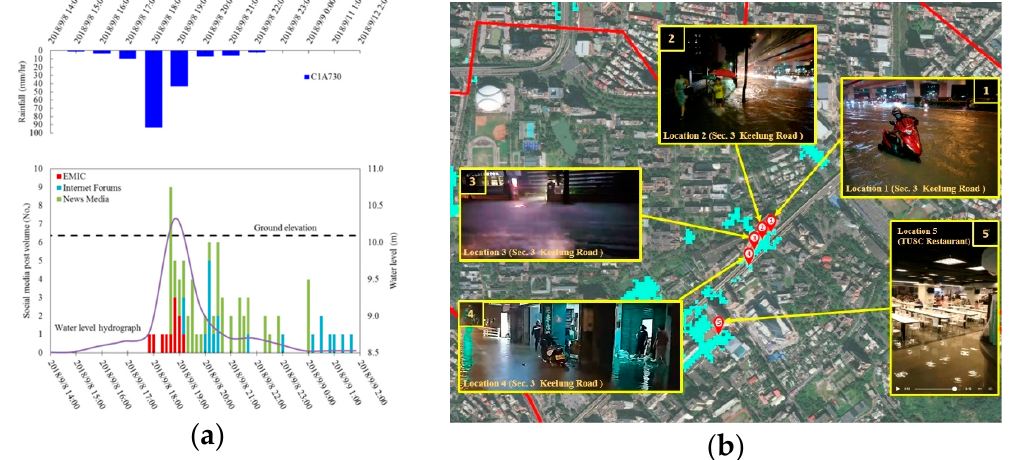
Figure 6. A comparison of simulation results with crowdsourced data for Heavy rain 0908 (2018) along Keelung Road: ( a ) rainfall, water level and social media post volume; and ( b ) crowdsourced data of flooding locations with photos captured in situ.